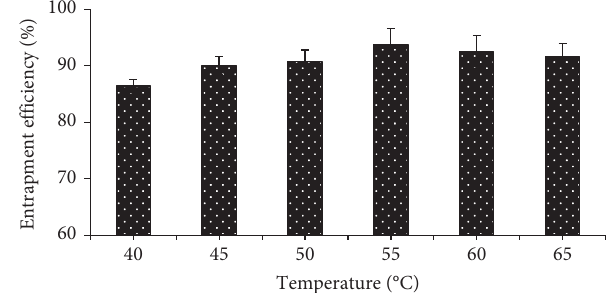
Figure 3: Effect of zein hydrolysis temperature on entrapment efficiency of lutein. The other hydrolysis conditions were kept constant: pepsin dosage 1.5%, hydrolysis time 4 h, and pH 3.0. Data were expressed as mean values ± standard deviation ( n � 3).